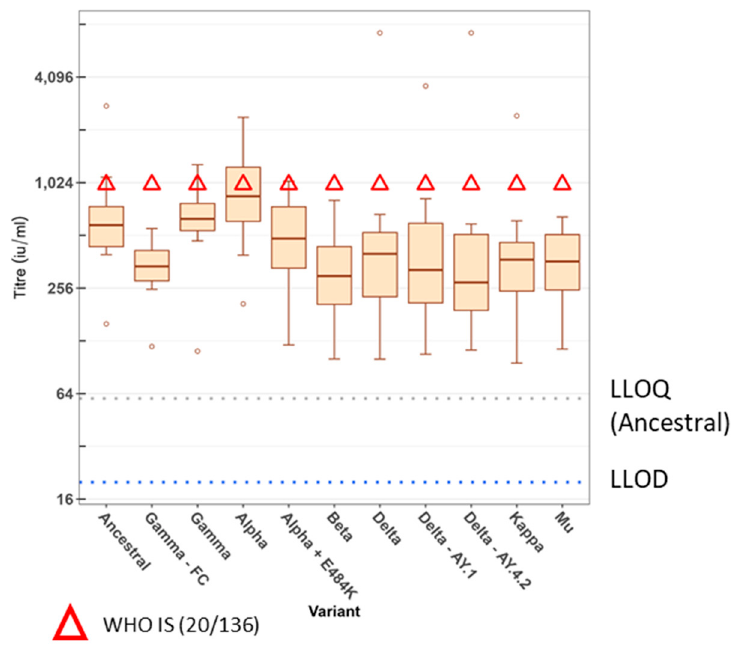
Figure 4. The effect of normalising antibody neutralising titres to the WHO International Standard (IS) 20/136 when comparing among SARS-CoV-2 variants. A panel of 11 pre-Alpha convalescent plasma and the WHO IS 20/136 were assessed for their neutralising capacity against authentic ancestral SARS-CoV-2 and a selection of variants using a FRNT assay. Neutralising titres are presented as IU/mL through normalisation to the WHO IS 20/136.